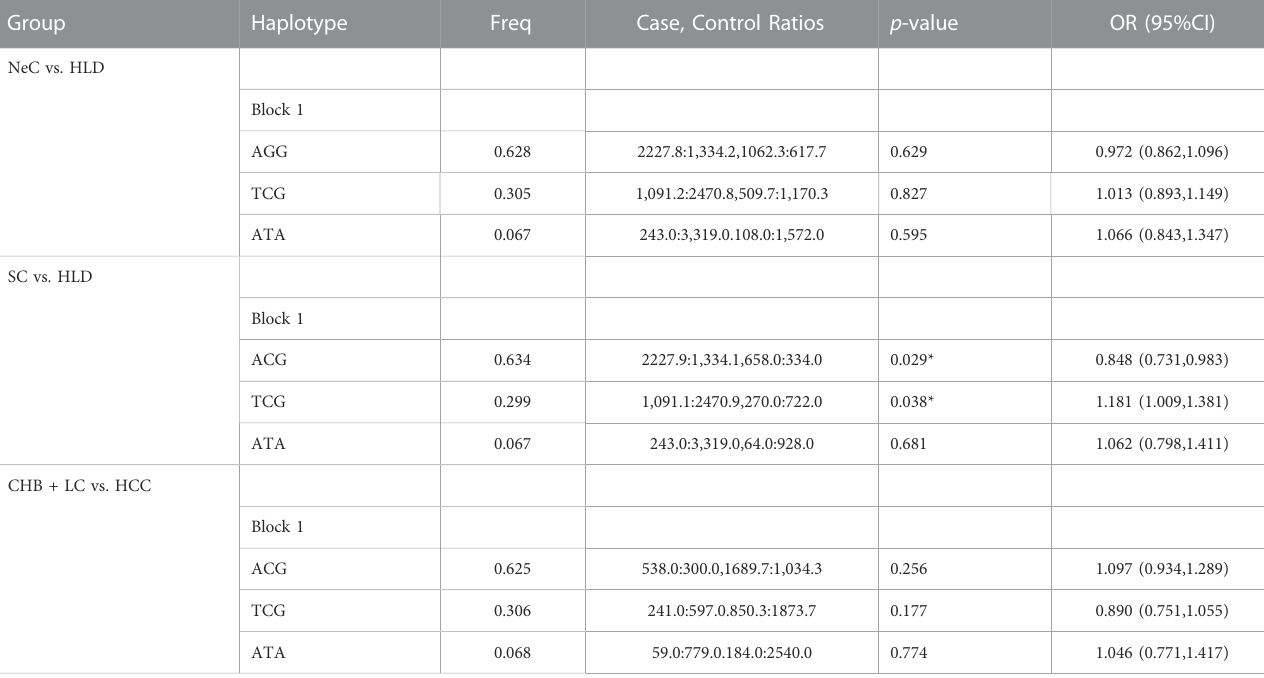
TABLE 2 Haplotype analysis for three SNPs within MLH1 gene in NeC vs. HLD, SC vs. HLD and CHB + LC vs. HCC by Haploview4.2. Group Haplotype Freq Case, Control Ratios p -value OR (95%CI) NeC vs.